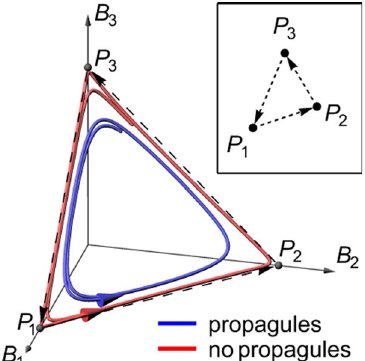
Fig. 3 Approximate heteroclinic networks underlie autonomous community turnover. The main panel shows two trajectories in the state space of a community of three hypothetical species (population biomasses B B B 1 , 2 , 3 ) that are in non-hierarchical competition with each other, such that no species can competitively exclude both others (a “ rock-paper- scissors game ” 17 ). Without propagule pressure, the system has three unstable equilibrium points ( P 1 , P 2 , P 3 ) and cycles between these (red curve), coming increasingly close to the equilibria and spending ever more time in the vicinity of each. The corresponding attractor is called a heteroclinic cycle (dashed arrows). Under weak extrinsic propagule pressure (blue curve), the three equilibria and the heteroclinic cycle disappear, yet the system closely tracks the original cycle in state space. Such a cycle can be represented as a graph linking the dynamically connected equilibria (inset). With more interacting species, these graphs can become complex “ heteroclinic networks ” 49 – 51 with trajectories representing complex sequences of species composition during autonomous community